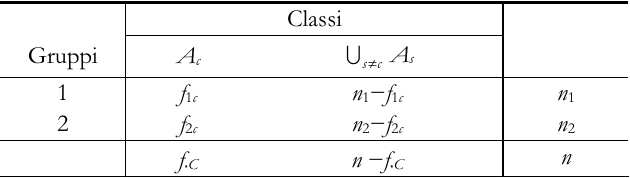
Sotto-tabella 2 × 2 relativa alla classe c